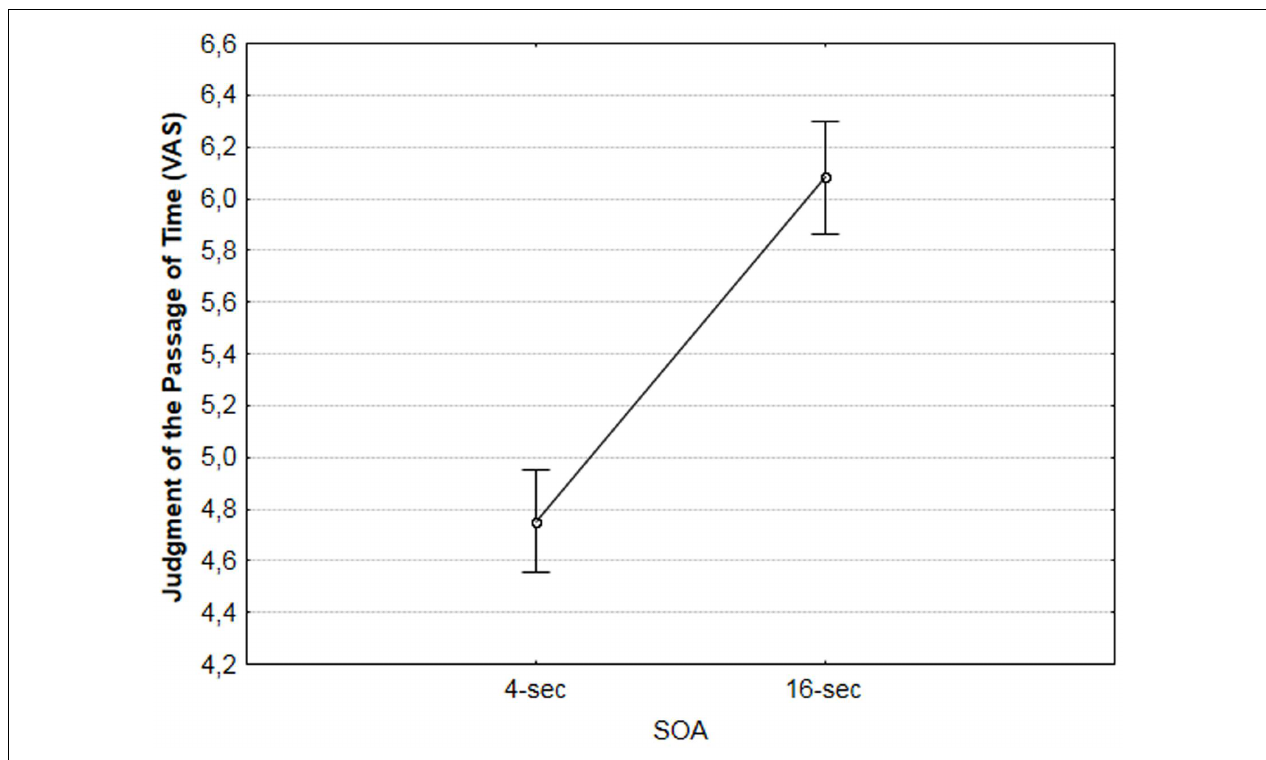
FIGURE 1 | Effect of the SOA between numbers on the judgment of the passage of time